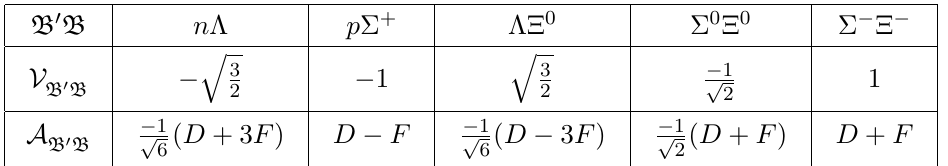
Table 1 . Values of V B 0 B and A B 0 B in eq. (3.1) for BB 0 = (cid:3) n; (cid:6) + p; (cid:4) 0 (cid:3) ; (cid:4) 0 (cid:6) 0 ; (cid:4) (cid:0) (cid:6) (cid:0) . The constants D and F come from the lowest-order chiral